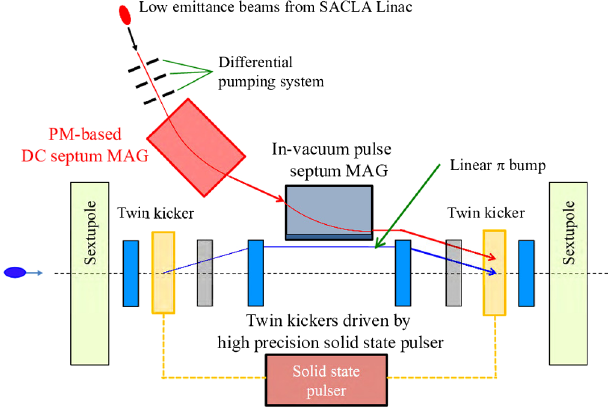
24FIG. 1. Proposed injector section of SPring-8-II [13].